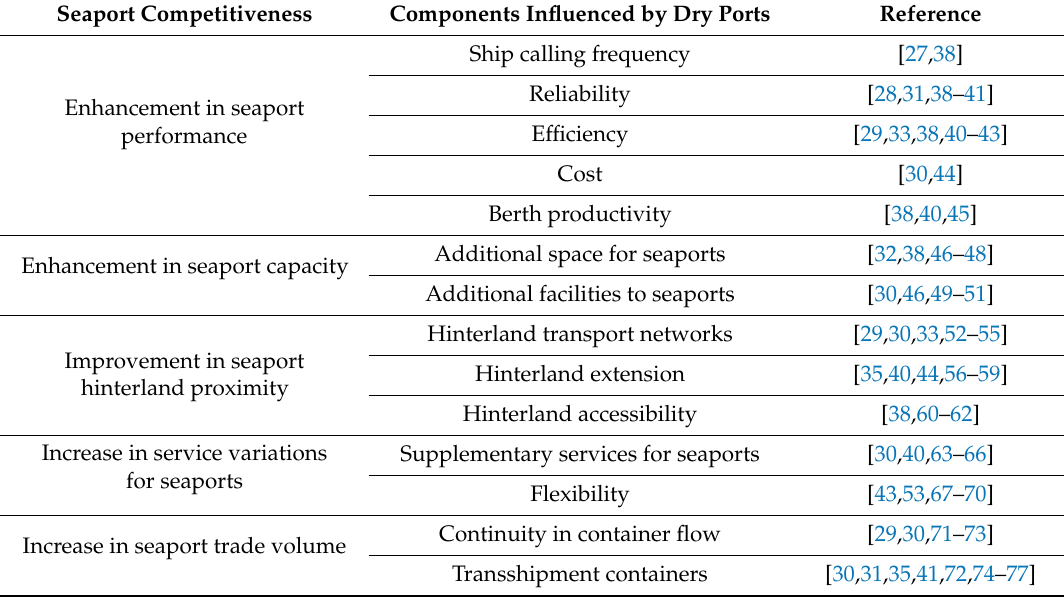
Table 2. Seaport